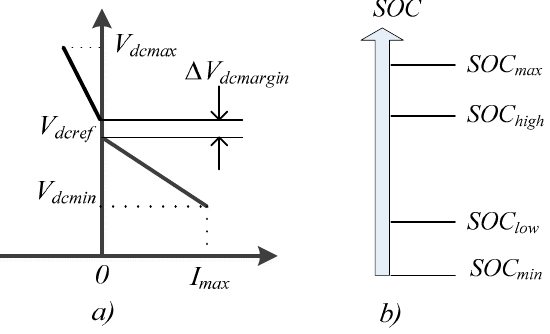
Figure 2. ( a ) Droop control method and ( b ) boundary level SOC of a battery storage system (BESS).